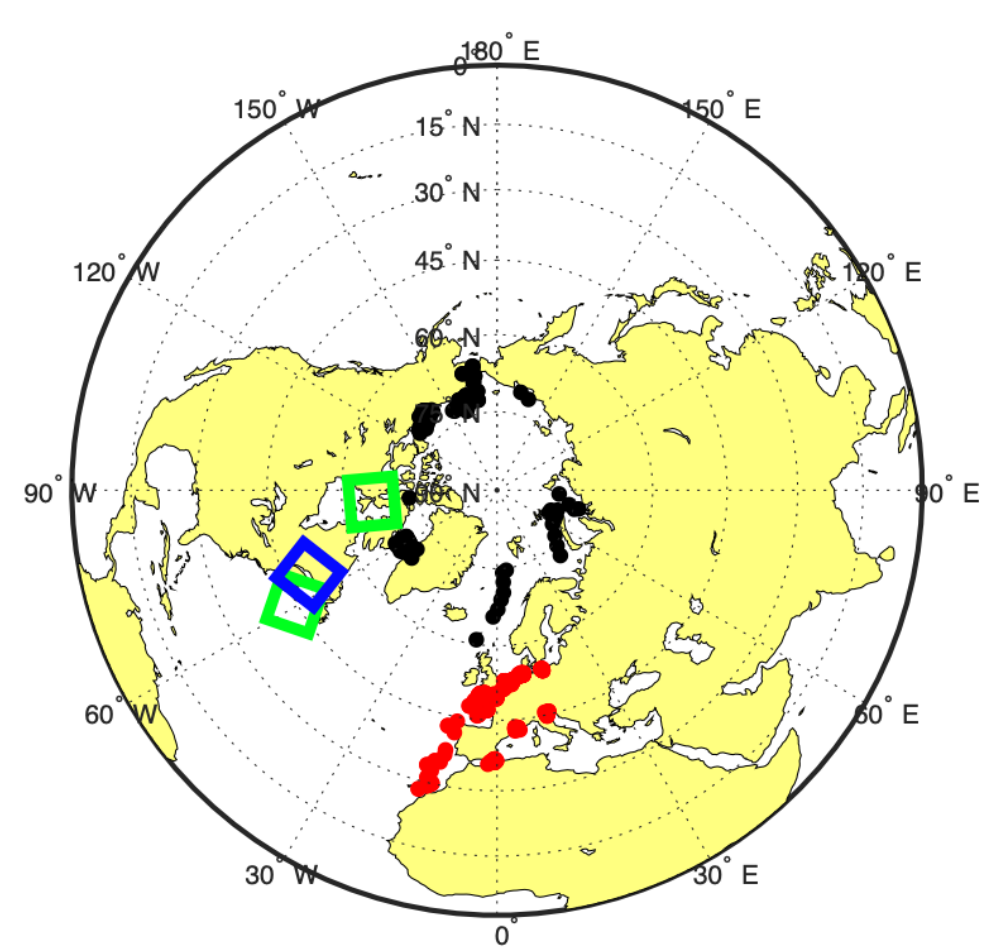
Figure 1. Location of the measurements. Red circles correspond to the COASTlOOC data and black circles to the Arctic dataset. The blue square shows the swath including the high northern latitude complex waters used for prediction (Section 2.1.2). The two green squares indicate the test sites used for predicting Chl-a in the Marginal Ice Zone, open and coastal waters (Appendix